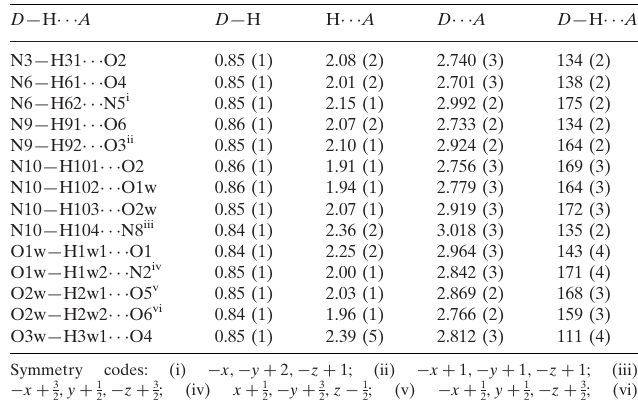
Hydrogen-bond geometry (A˚ , (cid:3)